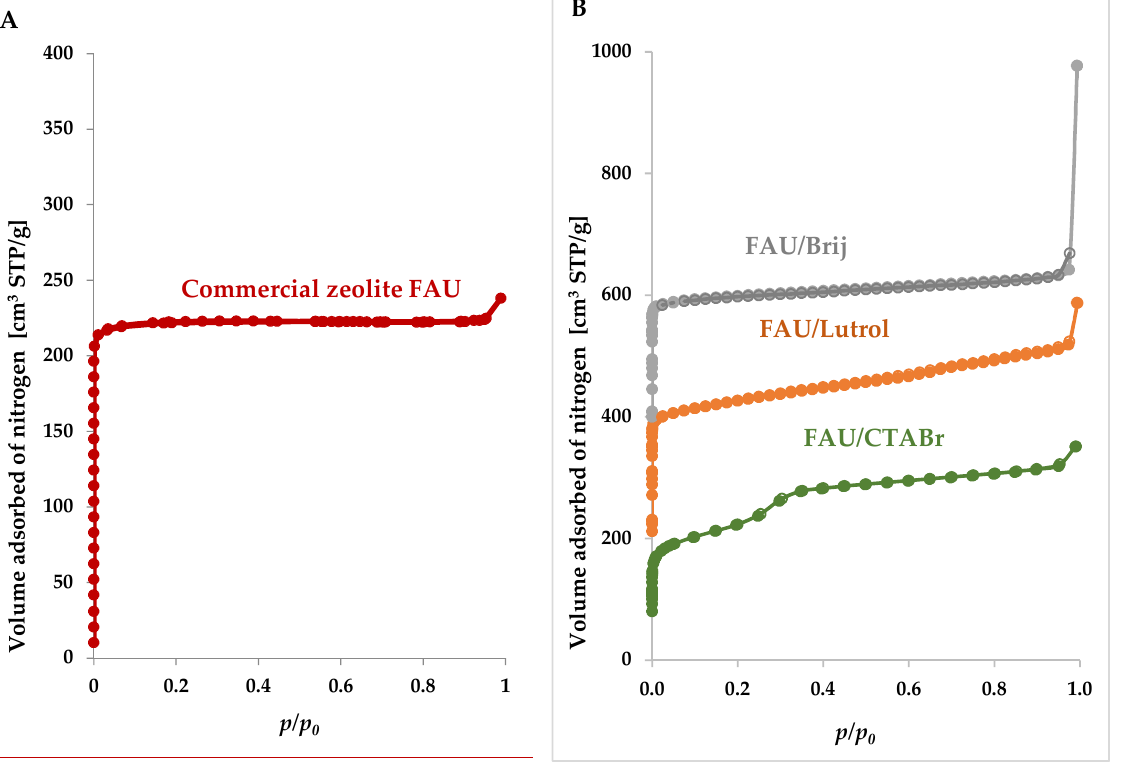
Figure 2. Nitrogen adsorption (filled circles)/desorption (open circles) isotherms for ( A ) FAU-type commercial zeolite and ( B ) hierarchical zeolites derived from FAU-type commercial zeolite. In panel B the top and middle isotherms are shifted by 400 and 200 cm 3 /g STP, respectively.